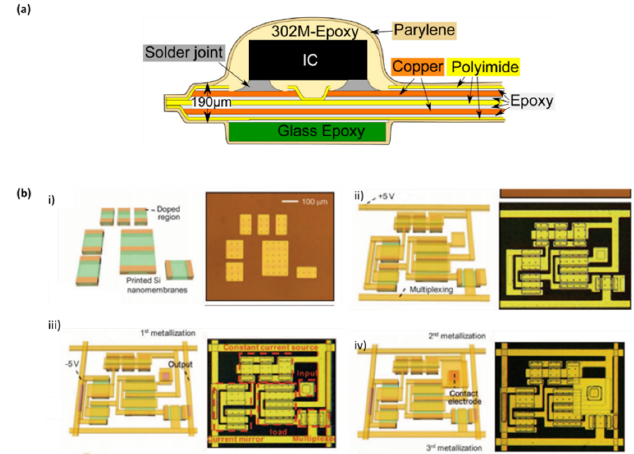
Figure 8. Fabrication techniques of implantable biosensors. ( a ) Structure of the polyamide foil with Cu tracks, mounted sensor and encapsulation in Implantable accelerometer system for the determination of blood pressure [135]. ( b ) Schematic illustrations and images of steps for fabricating active, conformal electronics for cardiac electrophysiology. (i) Schematic illustration (left) and optical micrograph (right) of a collection of doped silicon nanomembranes in a unit cell. (ii) Configuration after fabrication of the source, drain, and gate contacts, with suitable interconnects and row electrodes for multiplexed addressing. (iii) Configuration after fabrication of the second metal layer, including the column output electrodes. (iv) Final layout after deposition of encapsulation layers and fabrication of the tissue-contacting electrode [136].